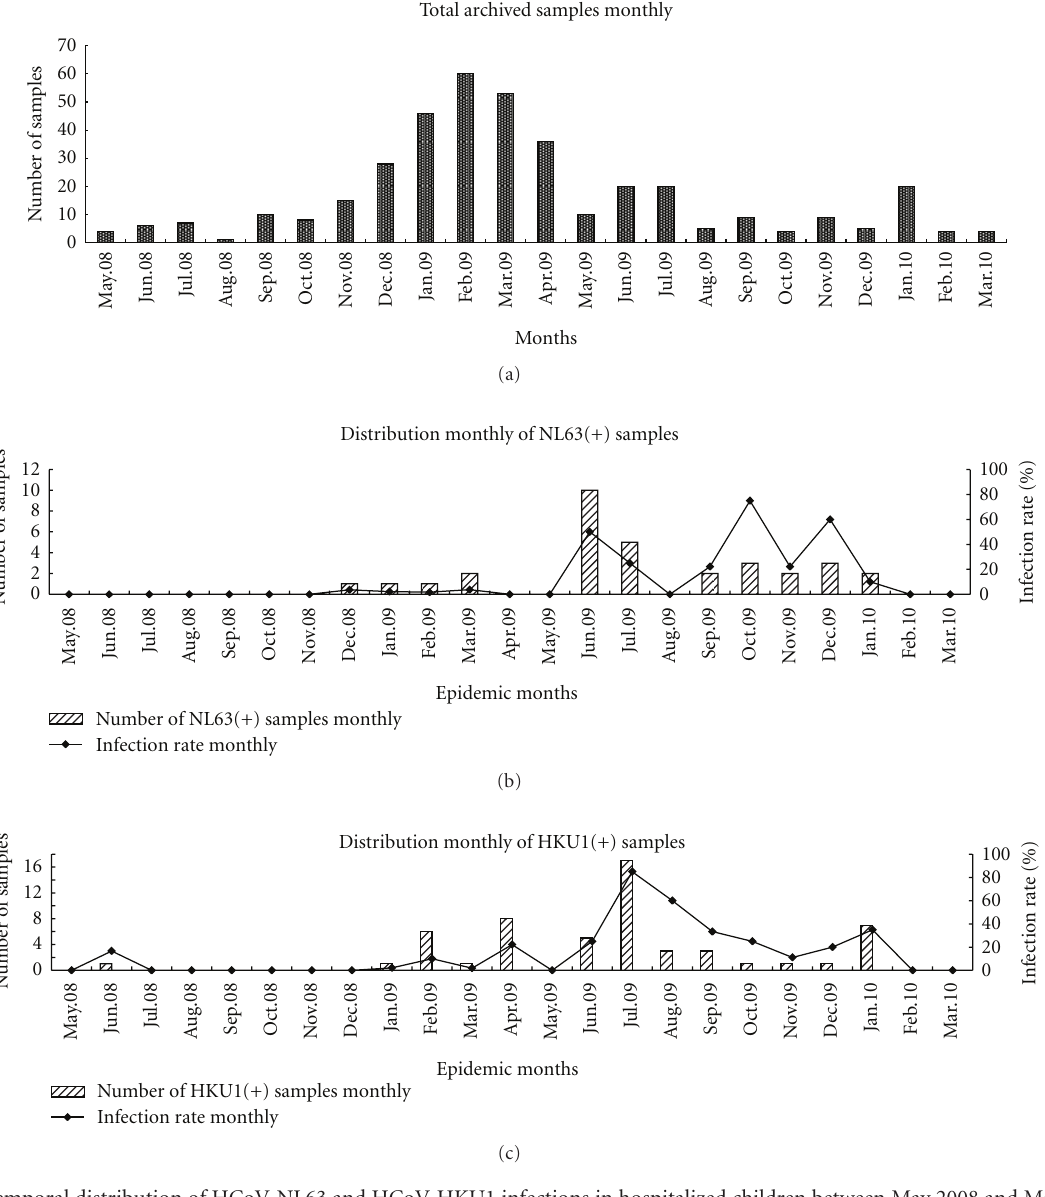
Figure 1: Temporal distribution of HCoV-NL63 and HCoV-HKU1 infections in hospitalized children between May 2008 and March 2010. (a) the number of specimens collected from children admitted with acute respiratory infections to the Beijing Children’s Hospital; (b) the number of positive specimens and percentage positive by month for HCoV-NL63; (c) the number of positive specimens and percentage positive by month for